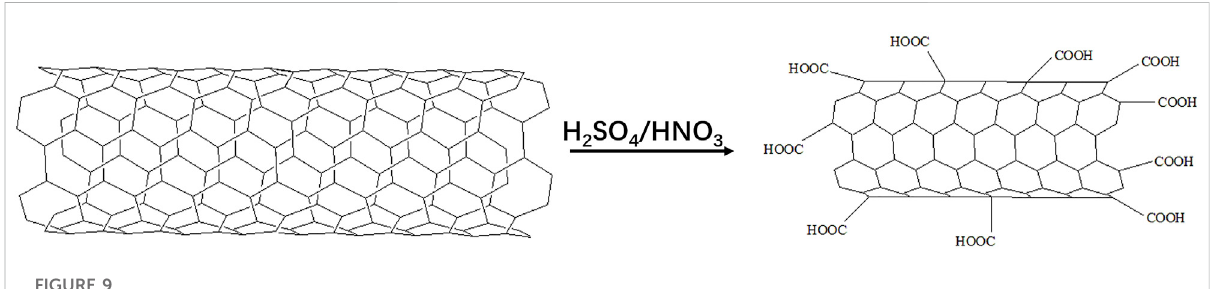
FIGURE 9 Functional principle of carbon nanotubes (Bianco et al.,